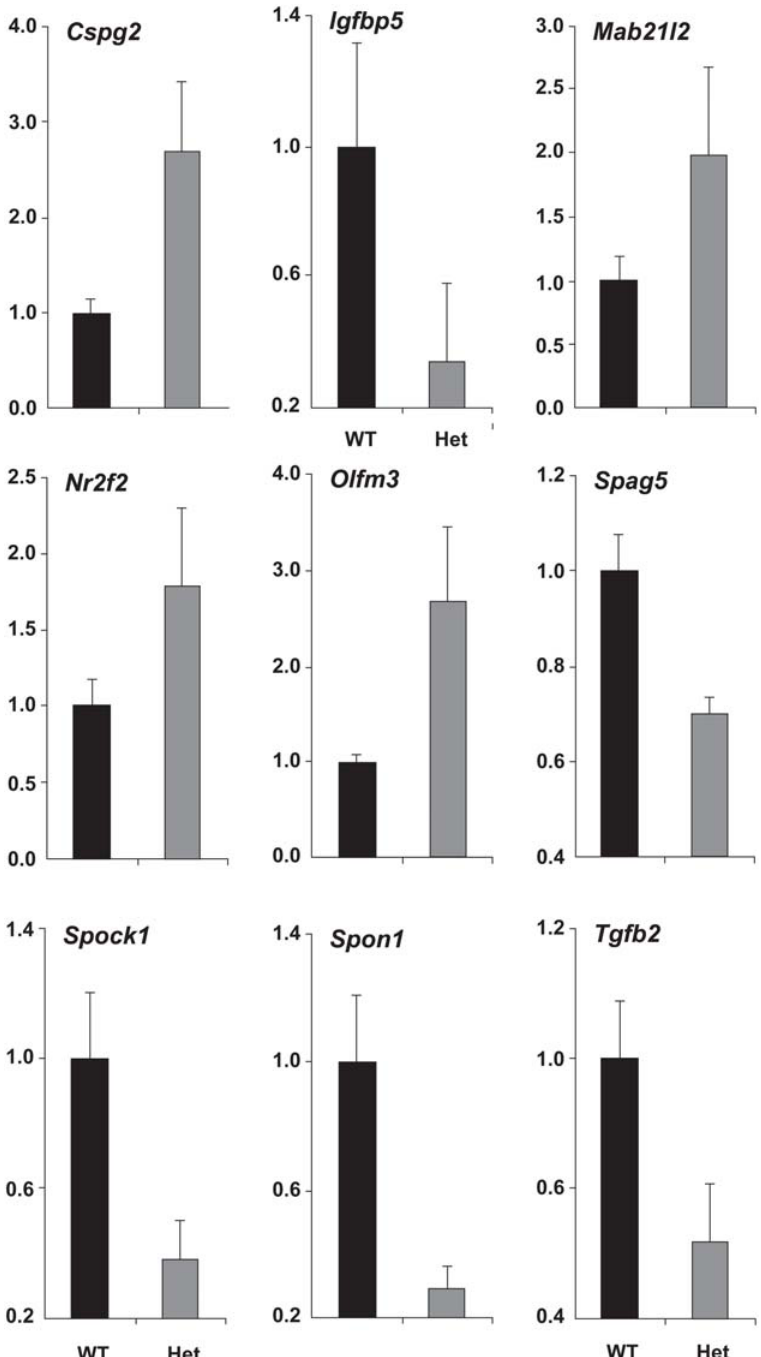
Figure 3. Verification of microarray results by qRT-PCR. Relative expression levels of Cspg2, Igfbp5, Mab21l2, Nr2f2, Olfm3, Spag5, Sparc, Spon1 and Tgfb2 transcripts in wild type (WT, shown in black) and Pax6 + / 2 (het, shown in grey) lenses were determined using qRT-PCR as described in Methods. Transcripts encoded by B2M, Hprt and Sdha, were tested as internal references [86], and all were found unchanged between the wild type and Pax6 + / 2 lenses. The data are expressed relative to the unchanged expression level of B2M